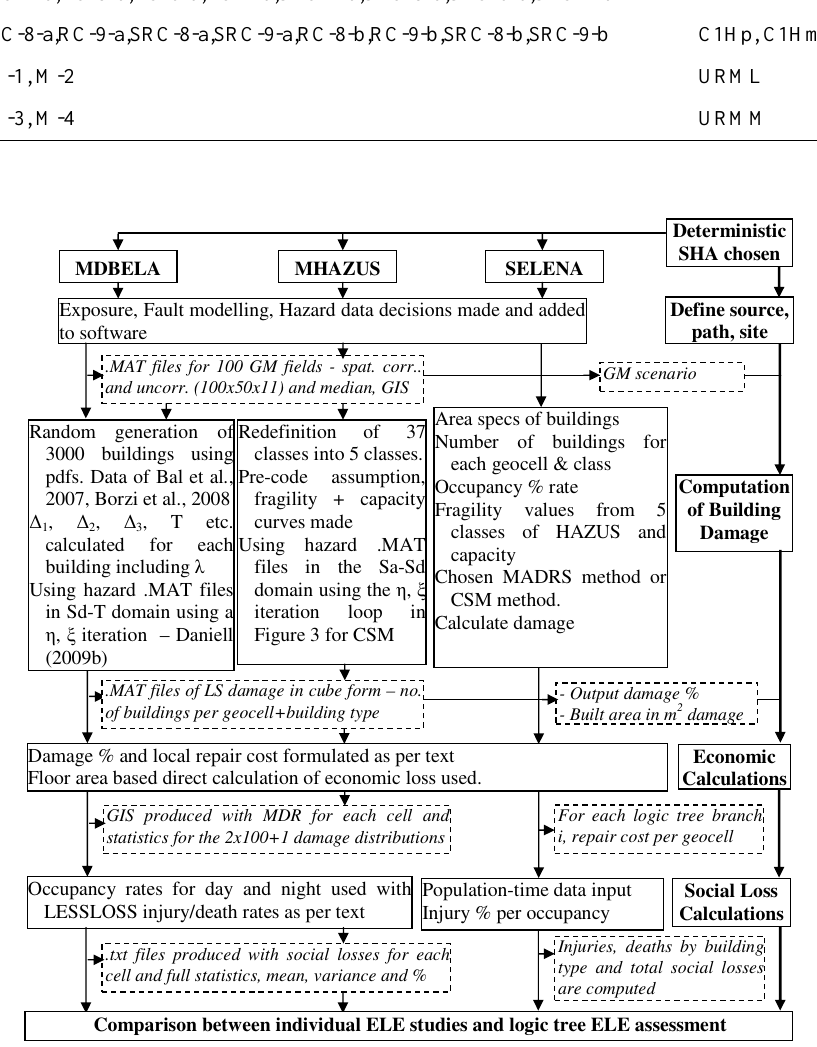
Figure 7. Process Flowchart for application of 3 ELE Software Packages 3 Fig. 7. Process flowchart for application of 3 ELE Software